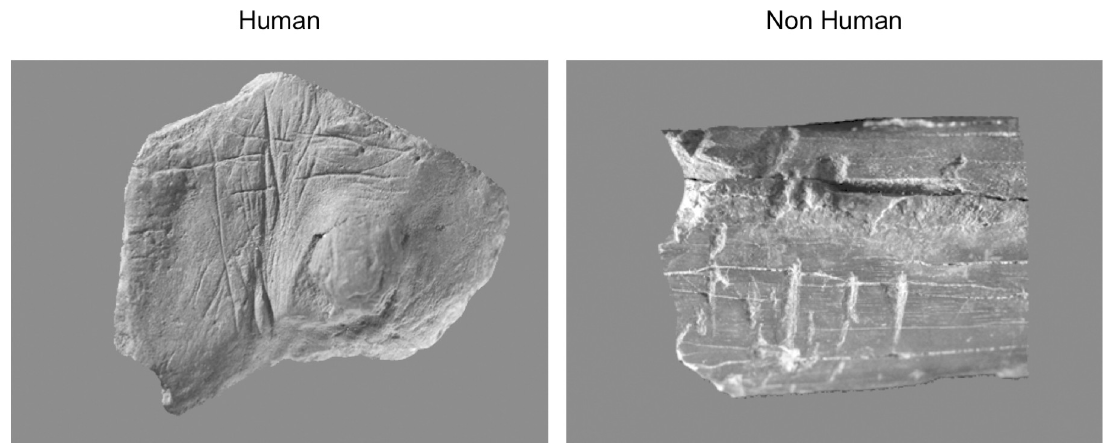
Fig 2. Examples of stimuli used in the judgment task. Left: human stimulus (engraving from Blombos Cave, Southern Africa, c. 77,000 years old). Right: non-human marks due to carnivore gnawing.